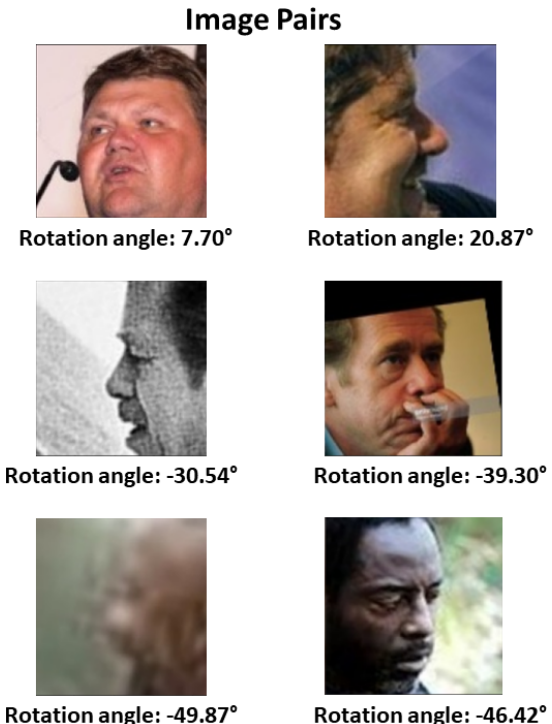
Figure 7. Example of image pairs with facial pose estimation error (attributed to the [0 ◦ ; 20 ◦ ] interval).